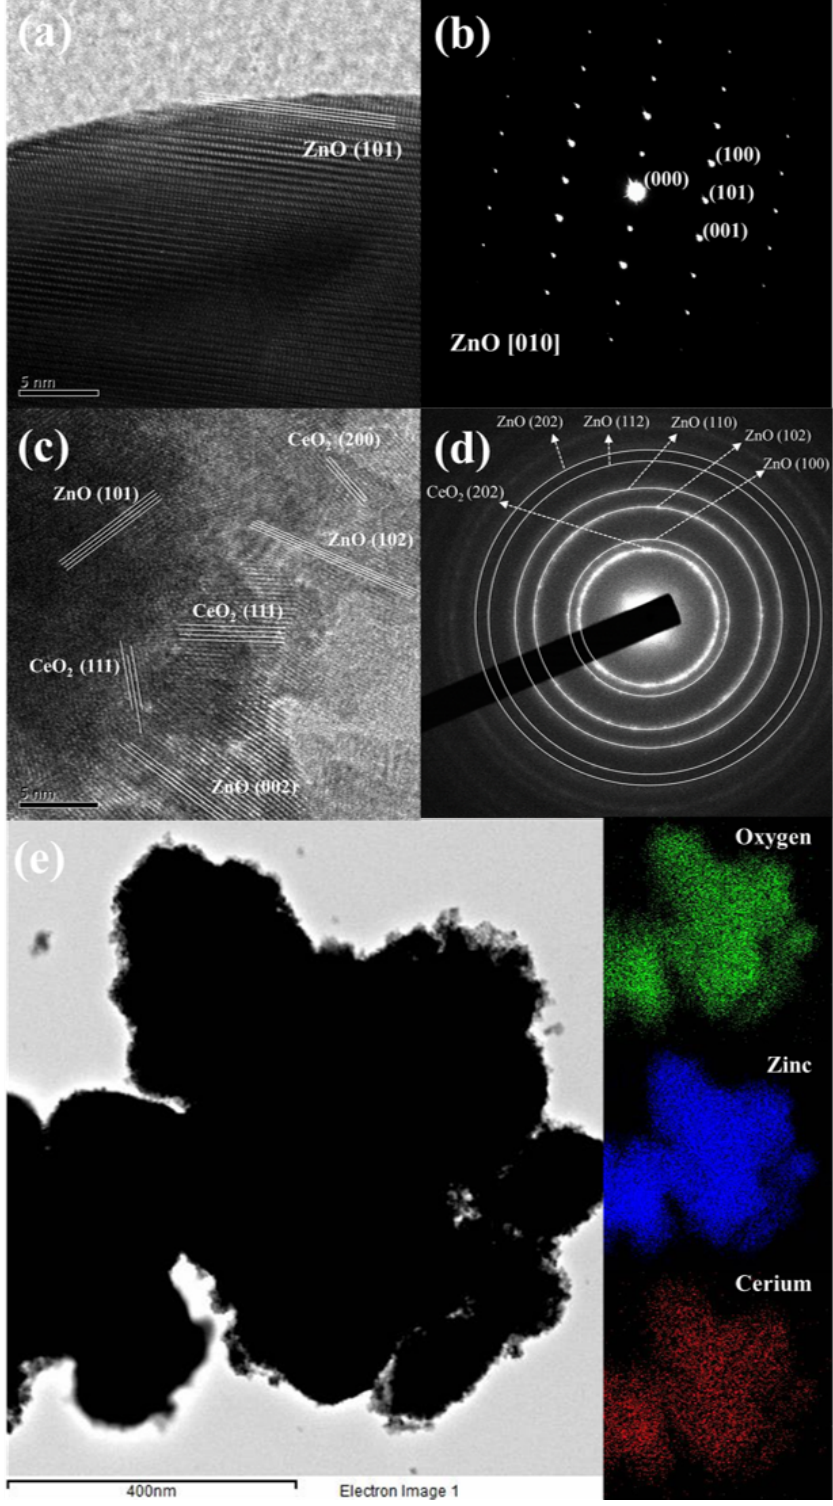
Figure 3. HR-TEM images and SAED patterns of ( a , b ) pristine ZnO and ( c , d ) 7% Ce/ZnO nanocomposites; ( e ) energy dispersive spectroscopy (EDS) mapping of 7% Ce/ZnO